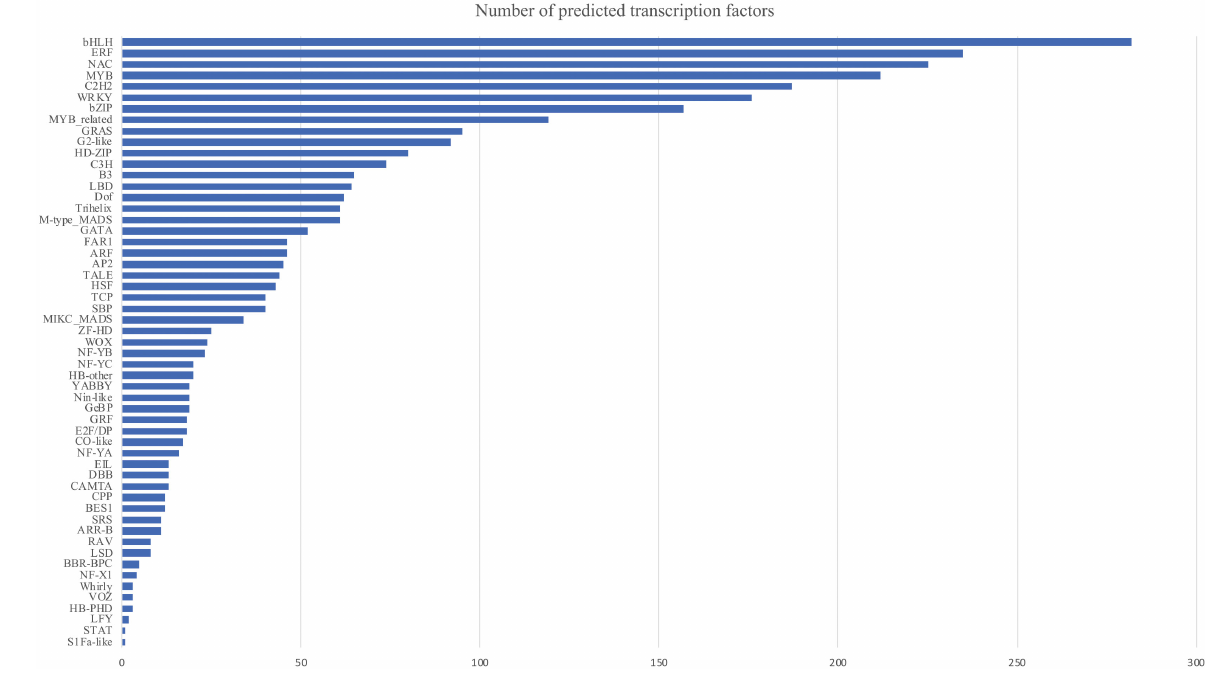
FIGURE 1 | Number of predicted transcription factors in Phragmites australis genome. The transcription factors were obtained by searching the annotated reference genome against the Plant TFDB V5.0. Genes annotated to the same transcription factor families were counted as one class. Details of transcription factor names can be retrieved from